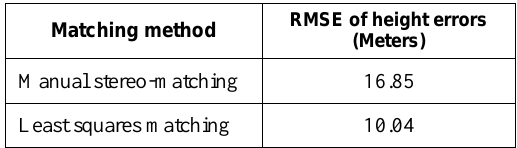
Figure 5. Distribution of VCPs over SRTM data The pixel coordinates of the VCPs, as discussed before, is onto the forward Cartosat-1 image using the ephemeris provided by the metadata. The corresponding pixel position on the forward image is determined using manual stereo-matching. With these VCPs the relative orientation of the stereo pair is performed. The solution of the system of equations converged with 4 iterations.